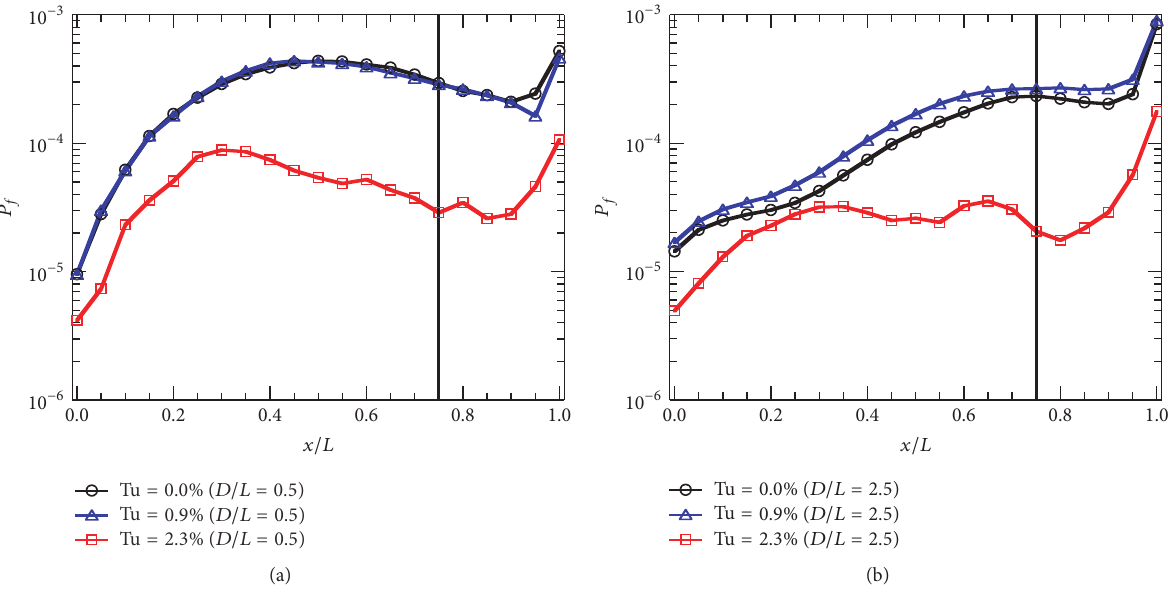
Figure 22: Power level of Lighthill’s stress tensor at the fundamental frequency, 𝑃 𝑓 , along y = 0. (a) Cavity flow without acoustic resonance ( D / L = 0.5). (b) Cavity flow with acoustic resonance ( D / L = 2.5).